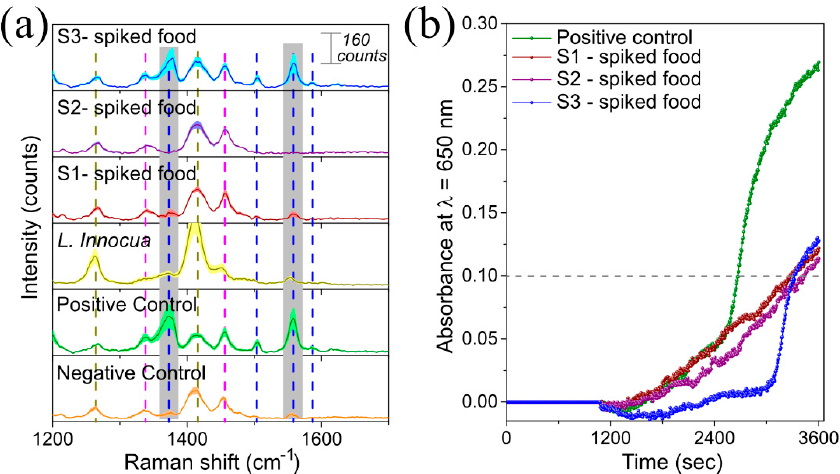
Figure 7. Ability of LAMP-on-a-chip SERS assay to detect L. monocytogenes in UHT milk. Briefly, 25 mL of UHT milk were inoculated with 10 (S1-spiked food), 90 (S2-spiked food), and 90 × 10 2 (S3-spiked food) CFU of L. monocytogenes (Table 1). Then, the target DNA was extracted and analyzed by LAMP. The detection was carried out by ( a ) SERS (i.e., using LAMP-on-a-chip SERS assay) and ( b ) turbidity (e.i. LAMP real-time turbidity detection) as reference. Both LAMP reactions were performed in the presence of 1NAT:GSH:lowTPEG -AuNPs at 62 ◦ C for 60 min. Positive control consists of pure target DNA extracted from L. monocytogenes at concentration of 10.2 µ g / µ L. In the negative control, sterilized water, and DNA extracted from L. innocua were added instead of target DNA. A positive reaction (i.e., detection of L. monocytogenes ) was indicated by the enhancement of SERS signal of 1NAT due to the AuNPs aggregation triggered by the complexation of GSH via its carboxylic groups and pyrophosphate generated as byproduct of DNA amplification with free Mg 2 + in the case of ( a ), and by increasing of the absorbance at 650 nm due to the formation of magnesium pyrophosphate crystals (possible interferences from the presence of AuNPs) in ( b ). In the graph shown in ( a ), dashed lines highlight the position of the Raman peaks corresponding to PDMS (dark yellow dashed line) and dNTPs of the master mix (magenta dashed line) and SERS peaks of 1NAT (blue dashed line). Gray shaded areas in ( a ) indicate the selected characteristic peaks of 1NAT (1368 and 1553 cm − 1 , ring stretching) to follow the variation of SERS signal respect to the generation of pyrophosphate ions during the DNA amplification (see Figure 6). Shadowed area in the spectrum represents the standard error of the mean (SEM) of 6–13 SERS